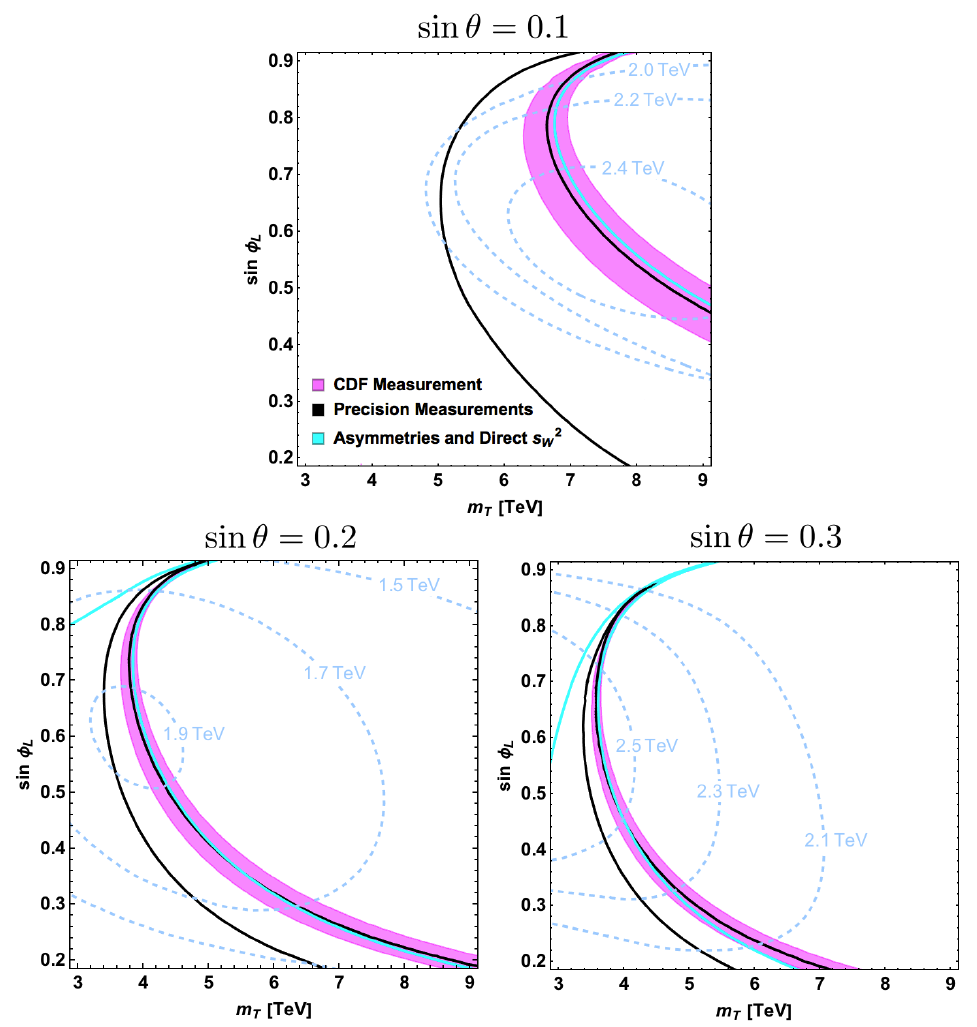
Figure 3 . Comparison of the new CDF measurement of the W mass (magenta band) to the m T - sin φ L parameter space of the minimal CH model for s θ = 0 . 1 , 0 . 2 , 0 . 3 , including the S and T contributions from both the fermion resonance singlet and fiveplet. Between the black lines the precision measurements are fulfilled, while the cyan lines indicate the bound stemming from asymmetries and direct s 2 determination. All bounds are shown at 2 σ confidence level and for W m V,A = 3 TeV, g = 3 and r = 0 . 8 . The dashed lines represent the top-partner singlet mass, m T e